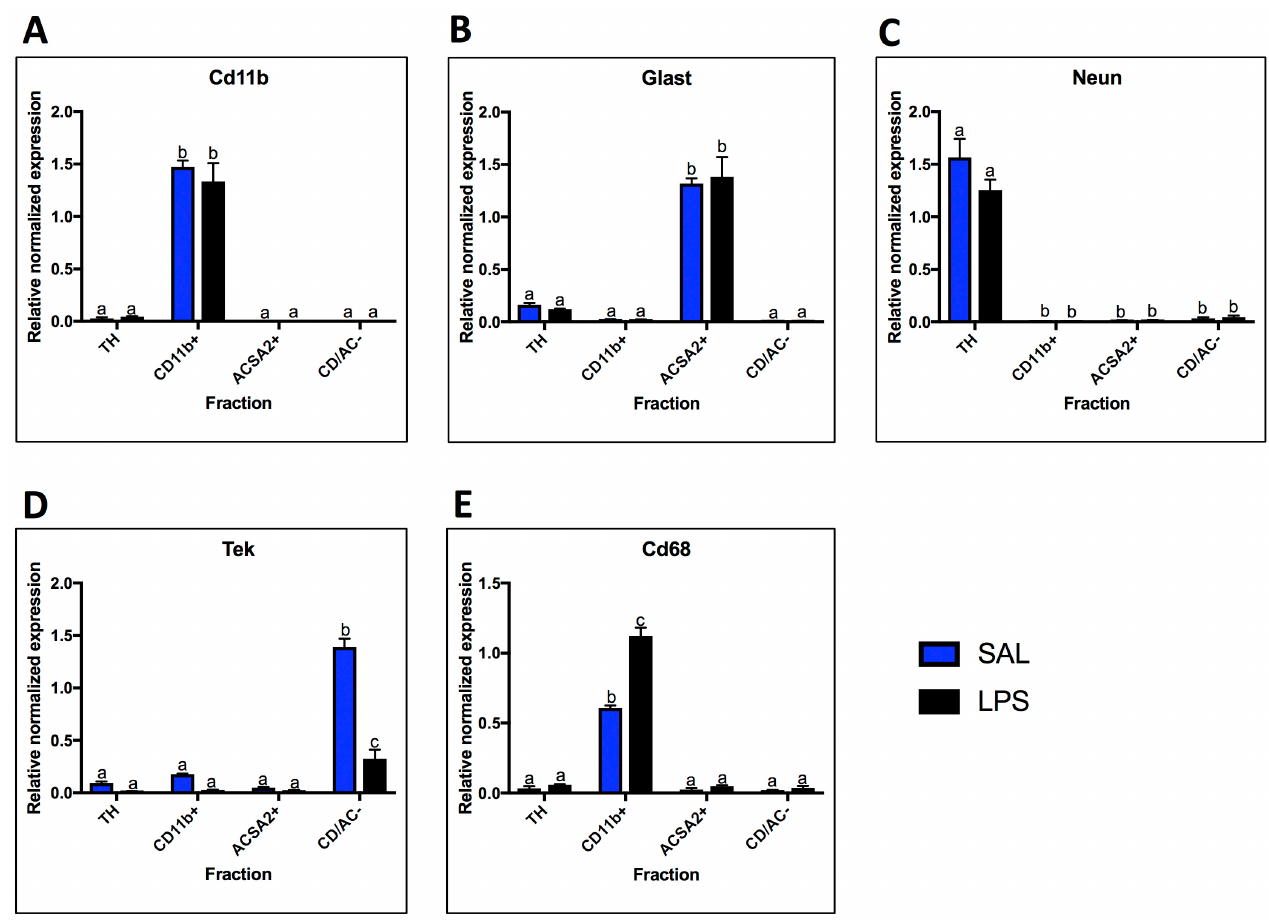
Figure 2. Cell-type marker mRNA expression. qPCR analysis of cell-type marker expression in the four fractions. A. The microglial fraction was highly enriched for the microglial marker Cd11b , and Cd11b was absent in the astrocyte and negative fraction. B. The astrocyte fraction was highly enriched for the astrocyte marker Glast , and expression of Glast was extremely low or absent in the microglial and negative fractions. C. The total homogenate (TH) had high expression of the neuronal marker Neun . Neun was absent from the microglial and astrocytes fractions and was expressed in low levels in the negative fraction. D. The endothelial cell marker Tek was highly expressed in the negative fraction and lowly expressed in the other three fractions. Tek expression decreased with LPS in the negative fraction. E. The activated microglial marker Cd68 was highly expressed in the microglial fraction, and lowly expressed in the other fractions. Cd68 expression increased with LPS in the microglial fraction. Two bars with the same letter are not statistically different; two bars with no letter in common are statistically different (two-way ANOVA with Tukey’s test for multiple comparisons, p<0.05). SAL, saline; LPS,